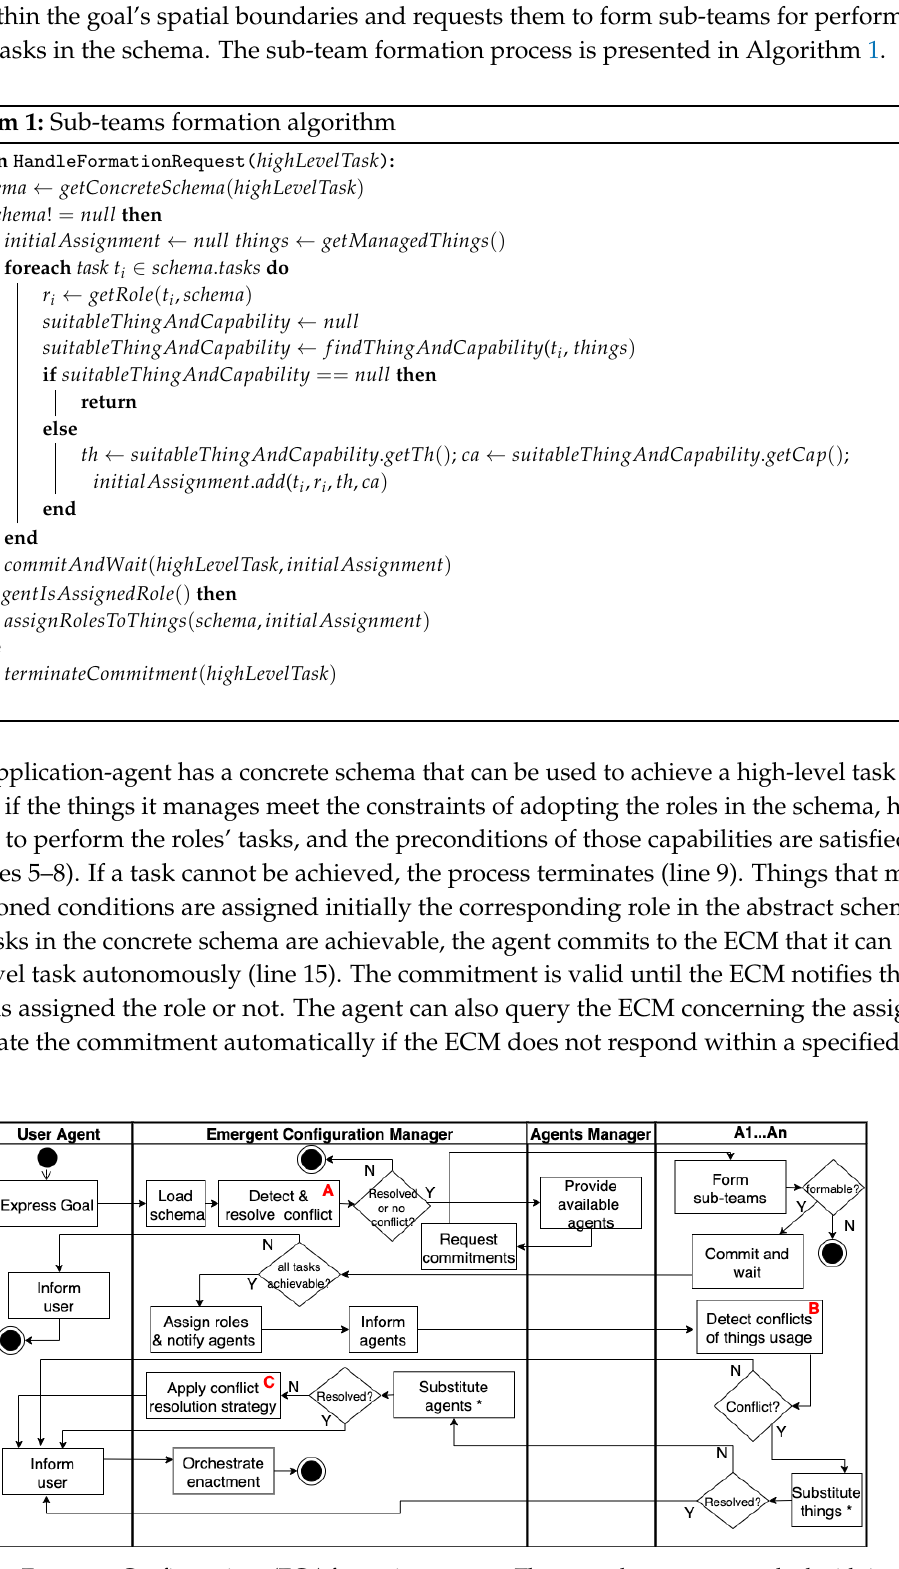
Figure 3. Emergent Configurations (ECs) formation process. The two sub-processes marked with * were not implemented in our prototype due to constraints imposed by the design of the used